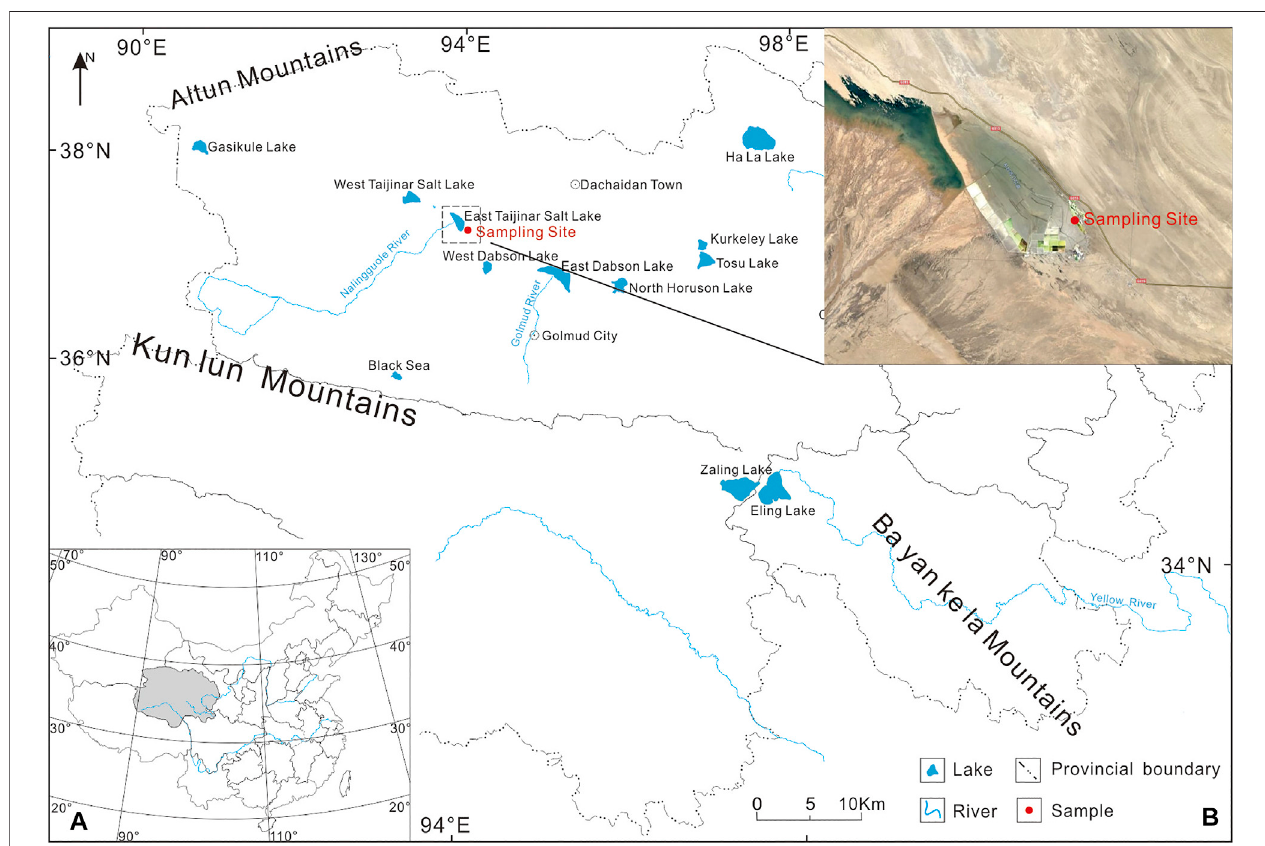
FIGURE1| MapofthesamplingsiteandlakesintheQinghaiProvince: (A) MapshowingthelocationofQinghaiProvinceinChinaand (B) Mapshowingthelocation of East Taijinar Salt Lake and the sampling site in the Qinghai Province.